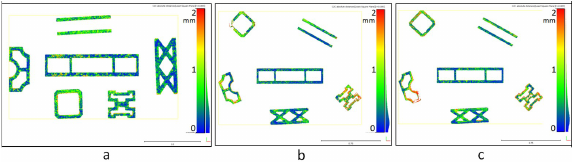
Figure 7. Comparison of 3D objects. (a) GoPro in air to Lumix in air (b) Lumix underwater to Lumix in air (c) GoPro